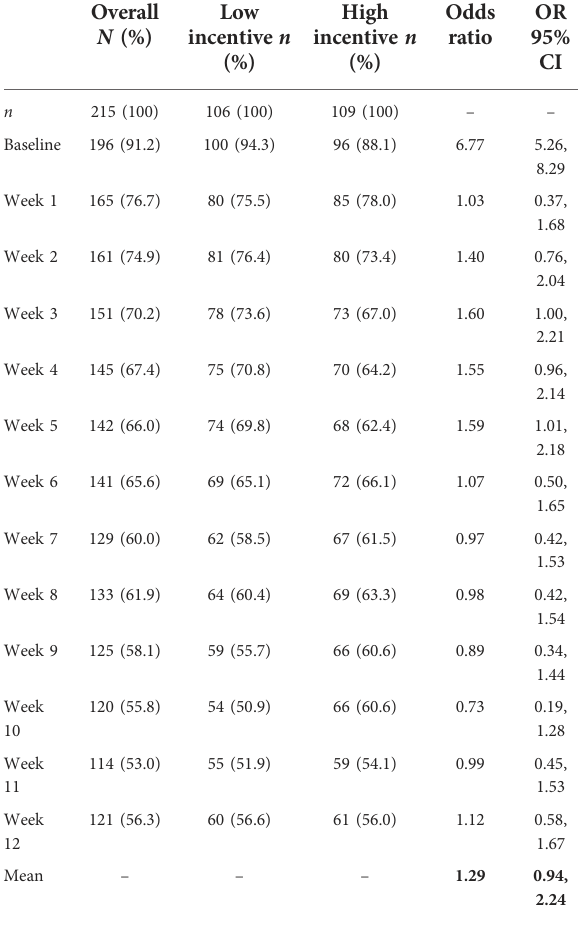
TABLE 2 Weekly measure completion rates and odds ratios. TABLE 3 Mean reported study burden and satisfaction by incentive